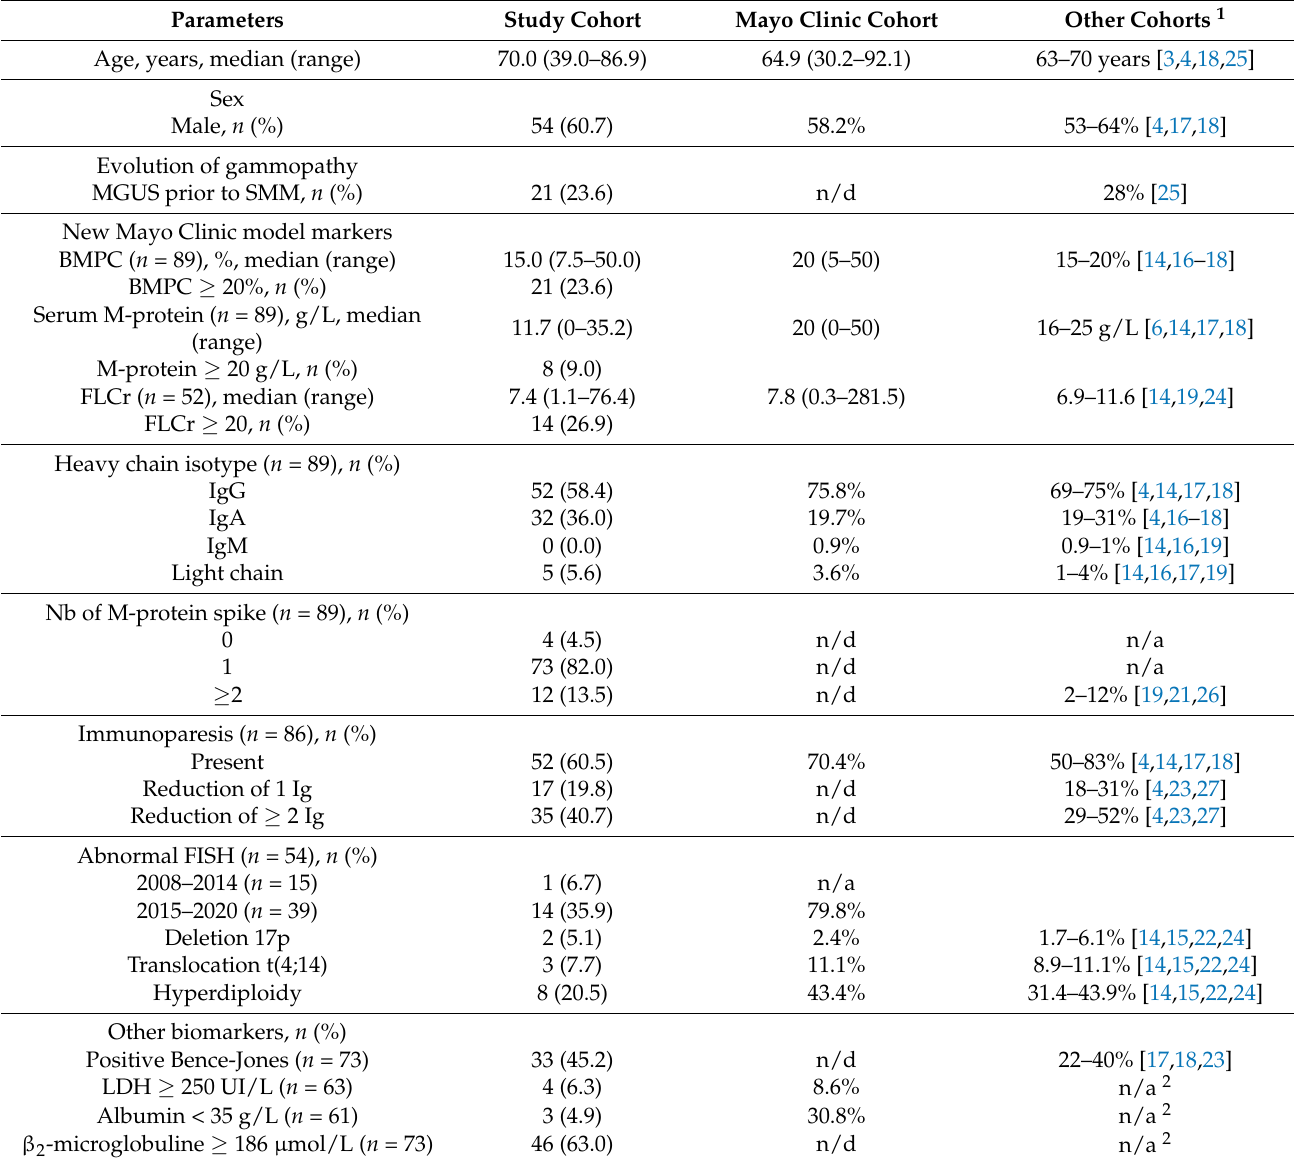
Table 2. Patients’ characteristics at diagnosis of SMM ( n = 89) compared to reported values in other SMM cohorts [3,4,14–27]. Parameters Study Cohort Mayo Clinic Cohort Other Cohorts 1 Age, years, median